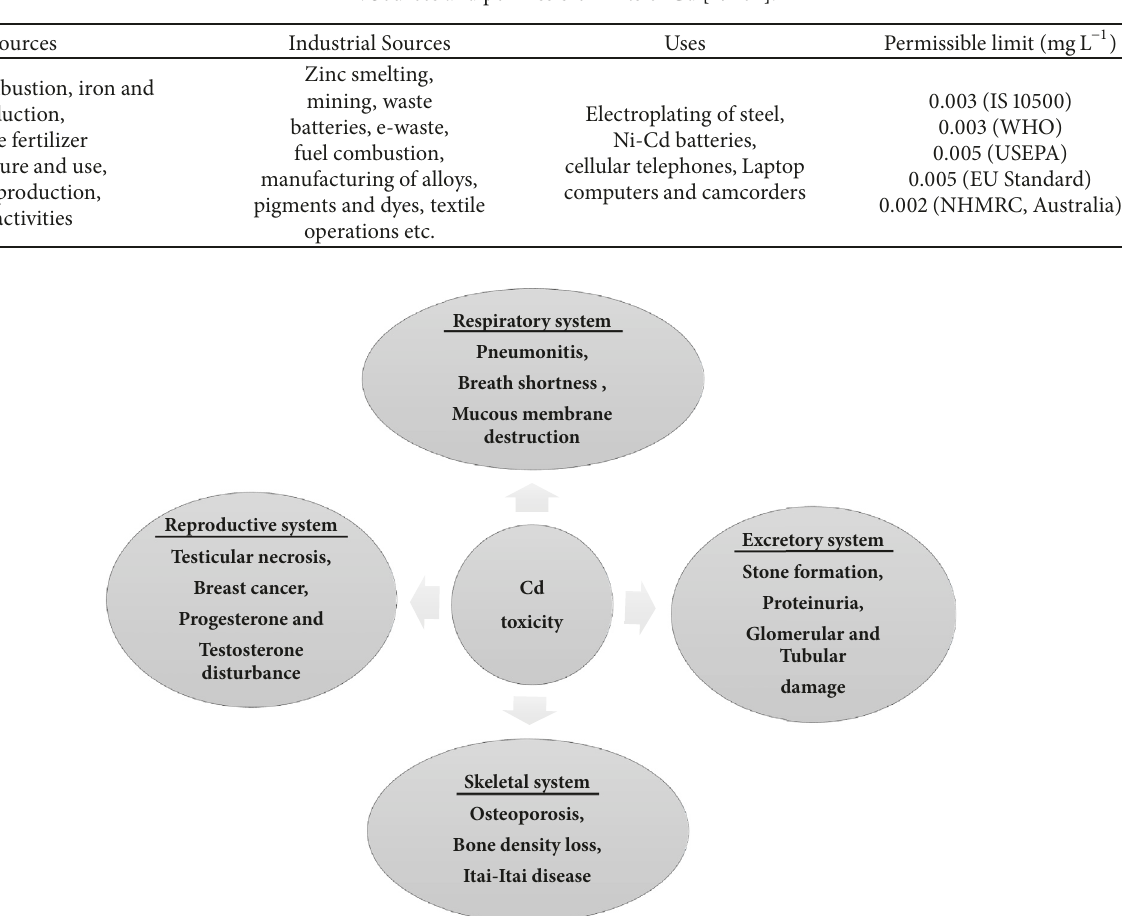
Figure 2: Cd effect on various organ system of human